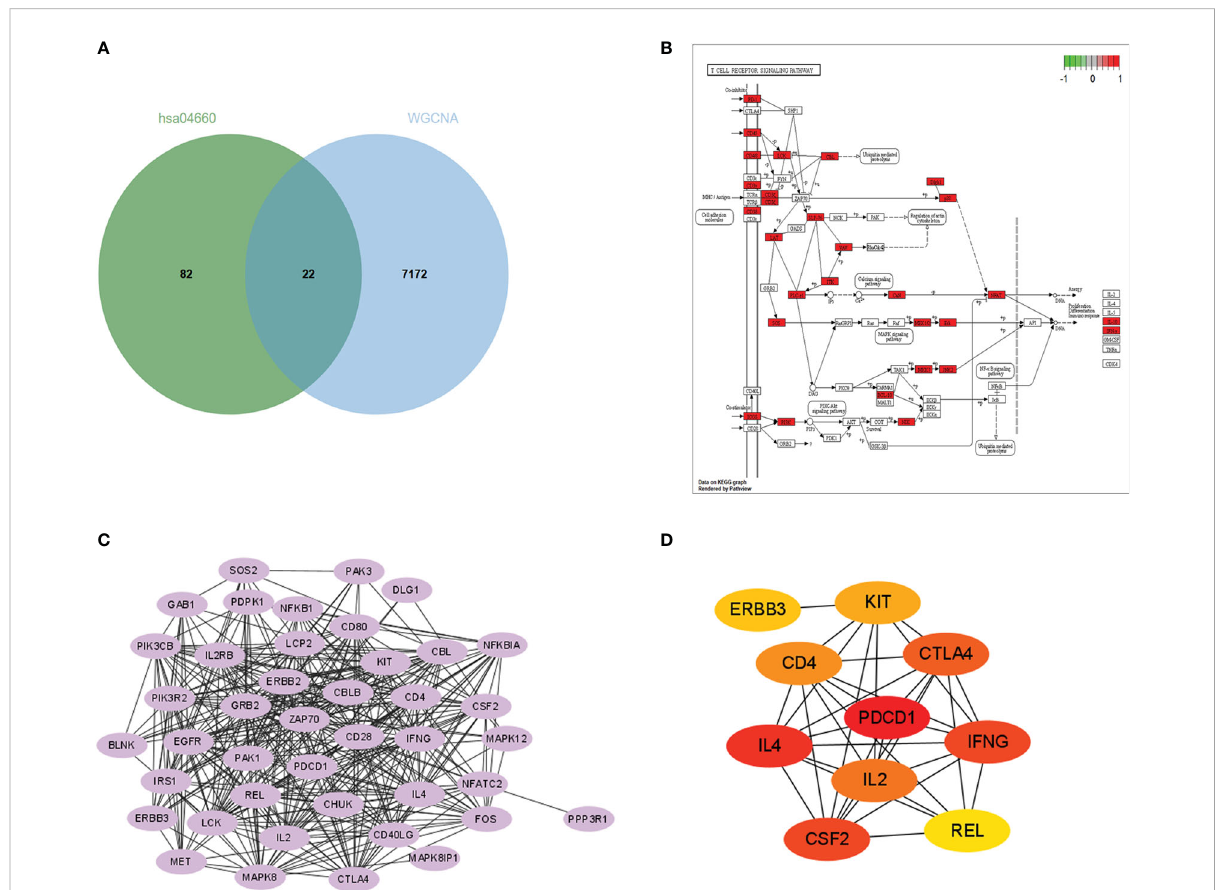
FIGURE 3 Hub gene identi fi cation: (A) Venn plot of genes in the midnightblue, mediumpurple3, and darkorange modules and genes in the T cell receptor signaling KEGG pathway (hsa 04660). (B) Enrichment of the 22 rejection-related genes in the hsa04660 KEGG pathway. (C) PPI network constructed with the 22 rejection-related genes. (D) Results of DMNC algorithm from Cytohubba (top 10